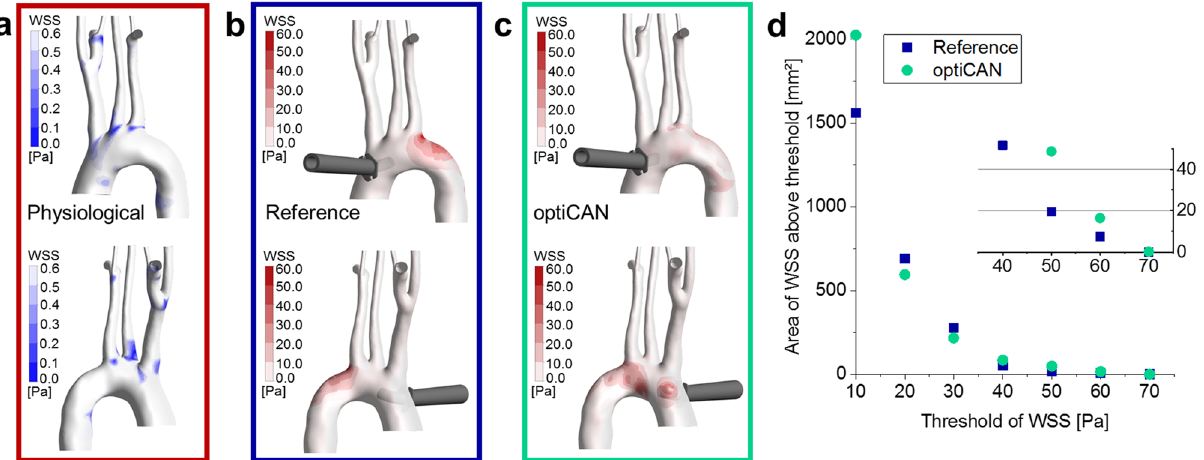
Figure 4. Wall shear stress (WSS) on the intima of the aortic arch. ( a ) WSS during physiological conditions in anterior (upper) and left lateral (lower) view. These can be prone to atherosclerotic plaque formation. ( b , c ) WSS during CPB for reference and optiCAN, respectively. High WSS resembles high impact on the intima and can lead to detachment of plaque. ( d ) Accumulated area of WSS above the critical threshold versus the respective critical threshold of WSS for both cannula designs. Inset shows a zoom for high thresholds of